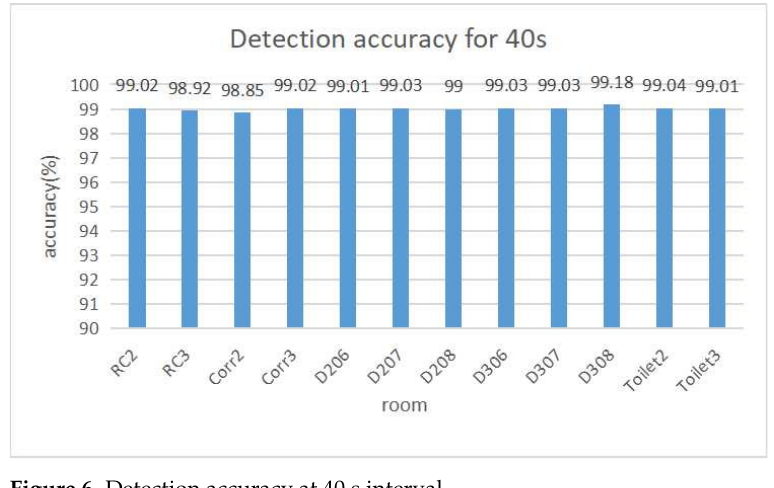
Figure 6. Detection accuracy at 40 s interval.